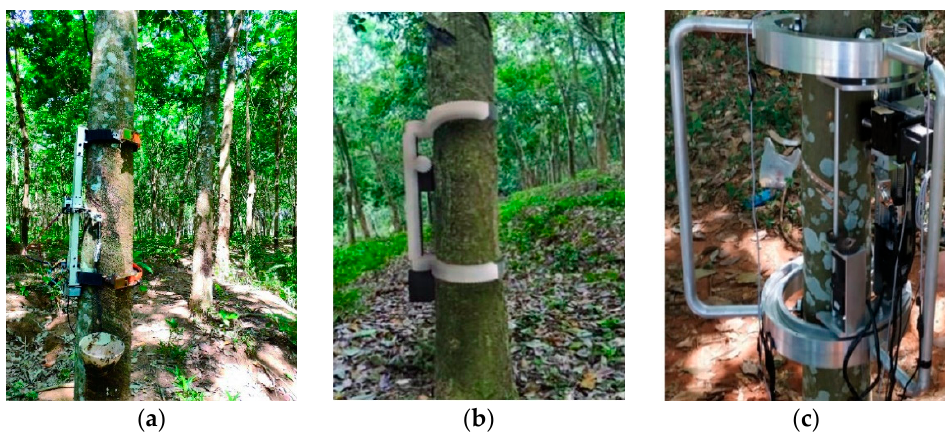
Figure 6. Fixed tapping machine. ( a ) Bundled profiled tapping machine [59] . ( b ) Fixed compound motion track rubber tapping machine [58] . ( c ) Rubber forest cutting test site [30] .